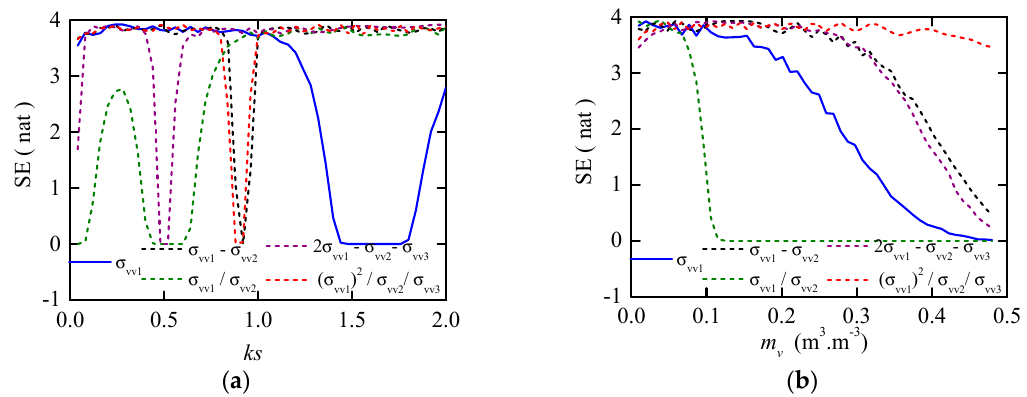
Figure 9. SE of the single and multi-angle when varying: ( a ) ks . kl = 5.0, m v = 0.2 m 3 m − 3 ; and ( b ) m v . ks = 1.0, kl = 5.0. σ VVi is the VV-polarized scattering coefficient with the incident angle θ i = 30 ◦ ,45 ◦ ,50 ◦ .